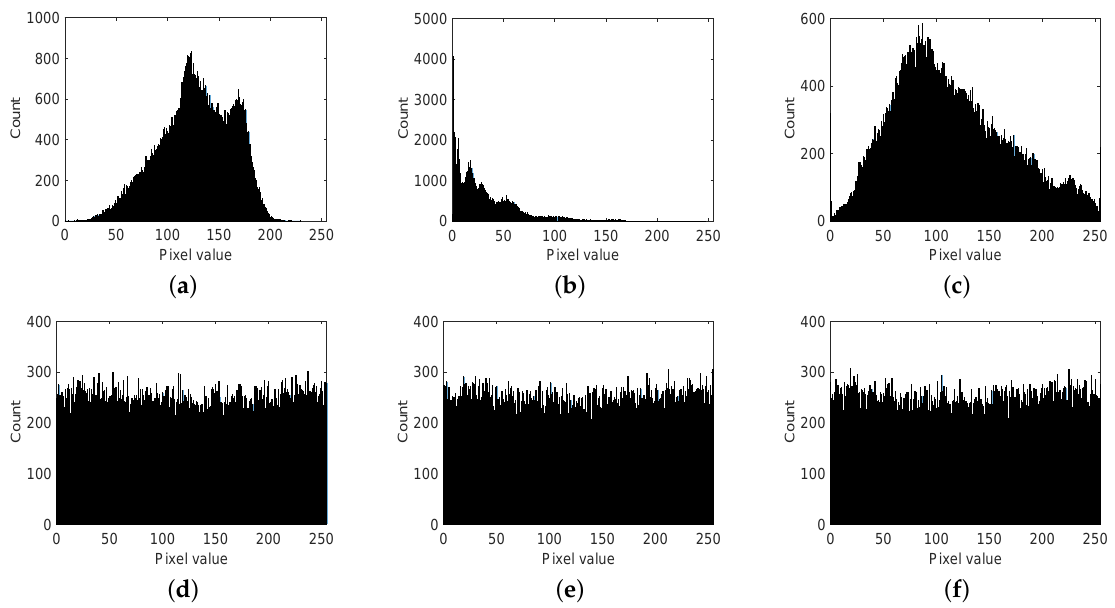
Figure 7. ( a ) Histogram of a plain image of a baboon. ( b ) Histogram of a plain image of a couple. ( c ) Histogram of a plain image of a bridge. ( d ) Histogram of a cipher image of a baboon. ( e ) Histogram of a cipher image of a couple. ( f ) Histogram of a cipher image of a